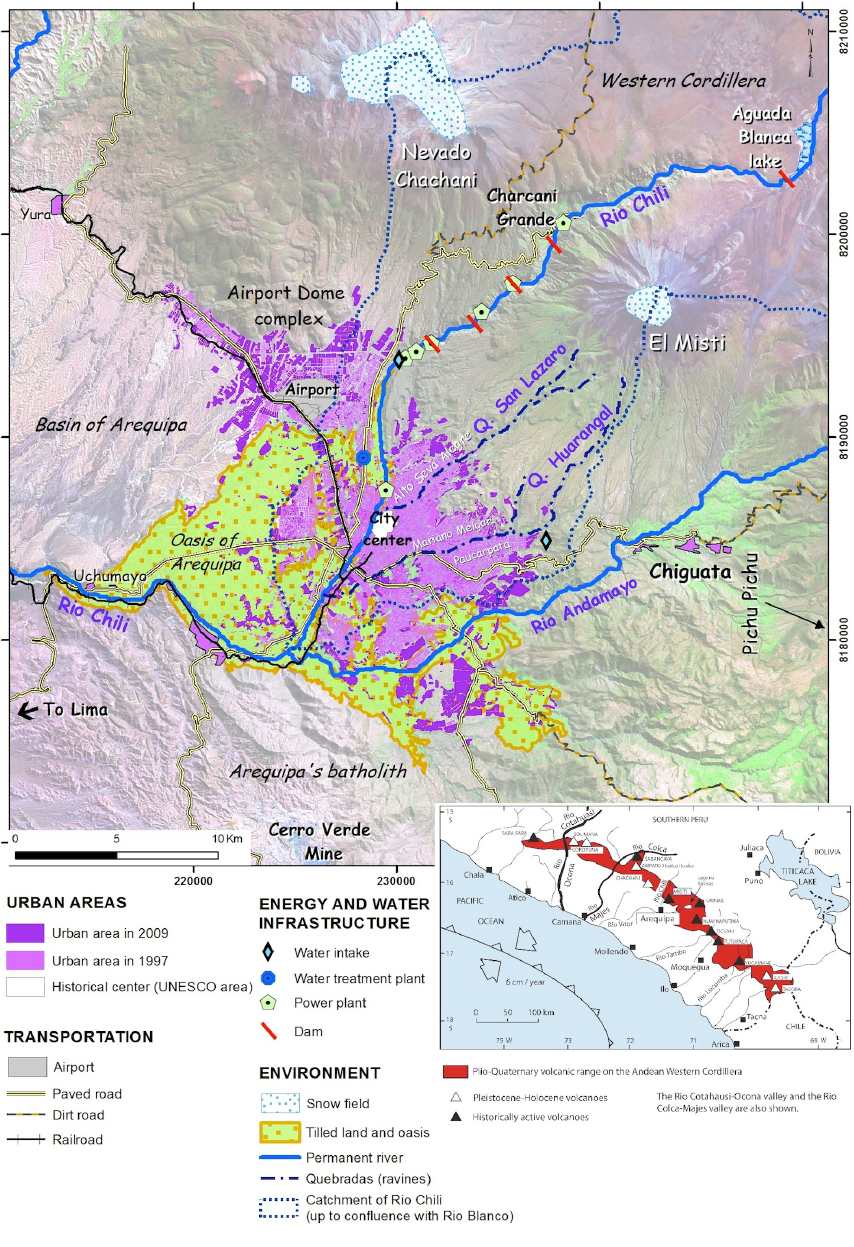
Fig. 1. The setting of Arequipa city in relation to El Misti volcano, showing the volcano, drainage and location of all quoted sites in